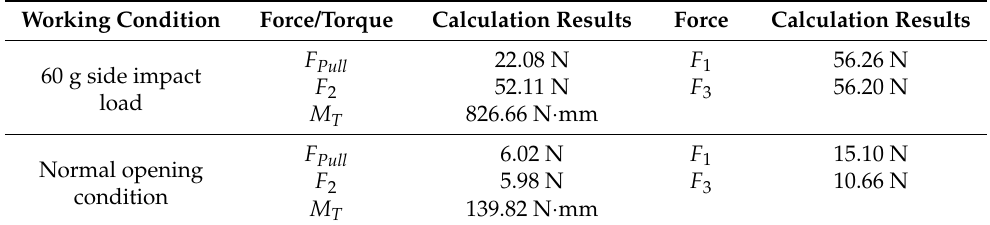
Table 6. The theoretical calculation results of the inertia load resistance of the door latch.